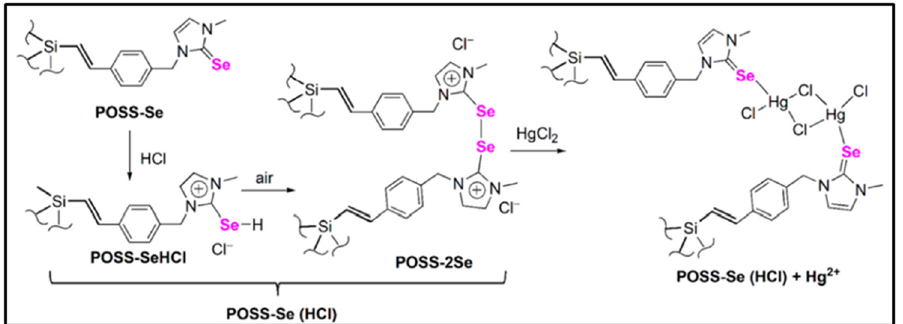
Figure 15. The possible mechanism of detecting Hg 2+ by POSS-Se after treating with HCl [93].